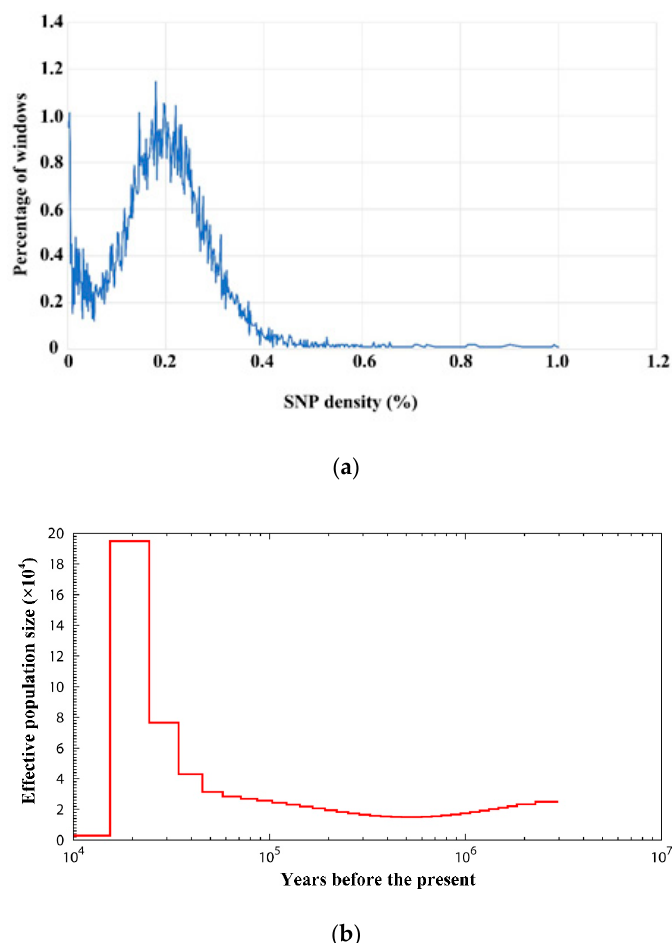
Figure 8. Single-nucleotide polymorphism (SNP) density distribution and demography reconstruction of Sichuan partridge. ( a ) Distribution of SNP density across Sichuan partridge genome. Heterozygous SNPs between the chromosomes were annotated, and heterozygosity density was observed in non-overlapping 50-kb windows. ( b ) Pairwise sequentially Markovian coalescent (PSMC) inference of Sichuan partridge population history on basis of autosomal data. The central bold lines represent inferred population sizes. The 100 thin curves surrounding each line are the PSMC estimates which were generated using 100 sequences randomly resampled from the original sequence. The mutation rate on autosomes used in time scaling, was estimated using chicken autosome data.